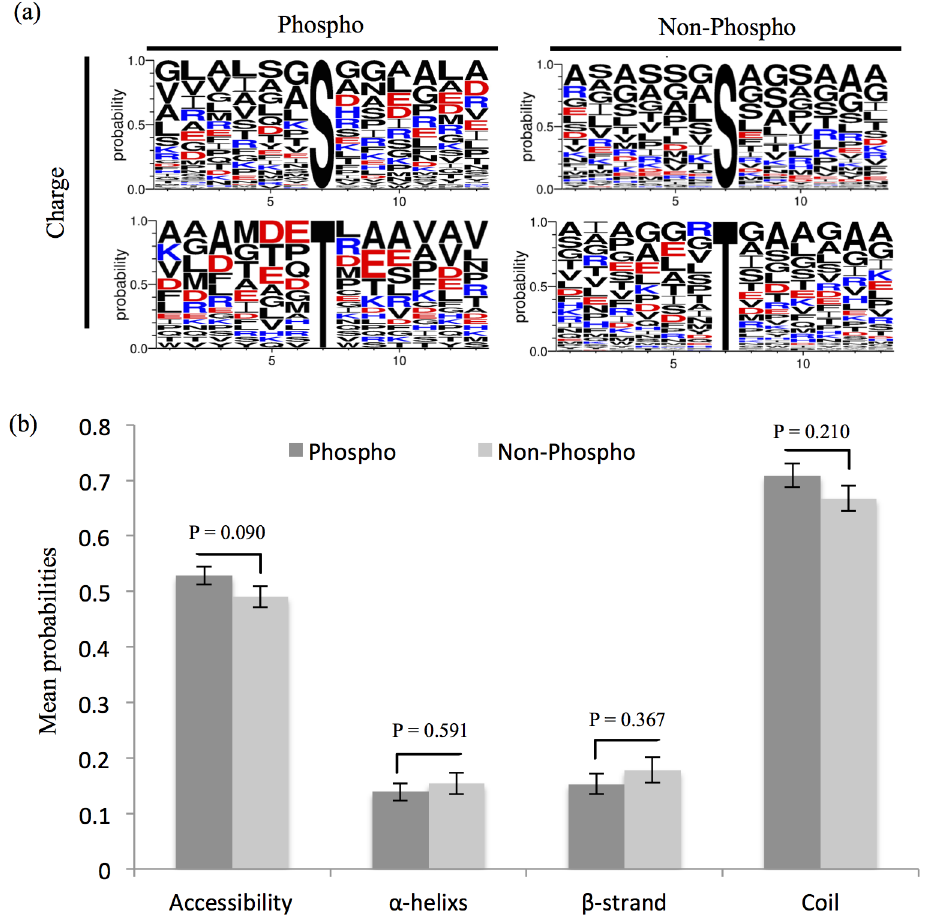
Fig 2. Bioinformatics analysis of phosphorylation sites. (a) Relative abundances of amino acids flanking pS/pT or non-phosphorylated Ser/Thr. Phospho-13-mers and non-phospho-13-mers (6 amino acids upstream and downstream of the phosphorylated or non-phosphorylated site) are shown. Amino acids are colored according to their charge scale. (b) Phosphorylated and non-phosphorylated Ser/Thr/Tyr in protein secondary structures. P-values based on T-test are